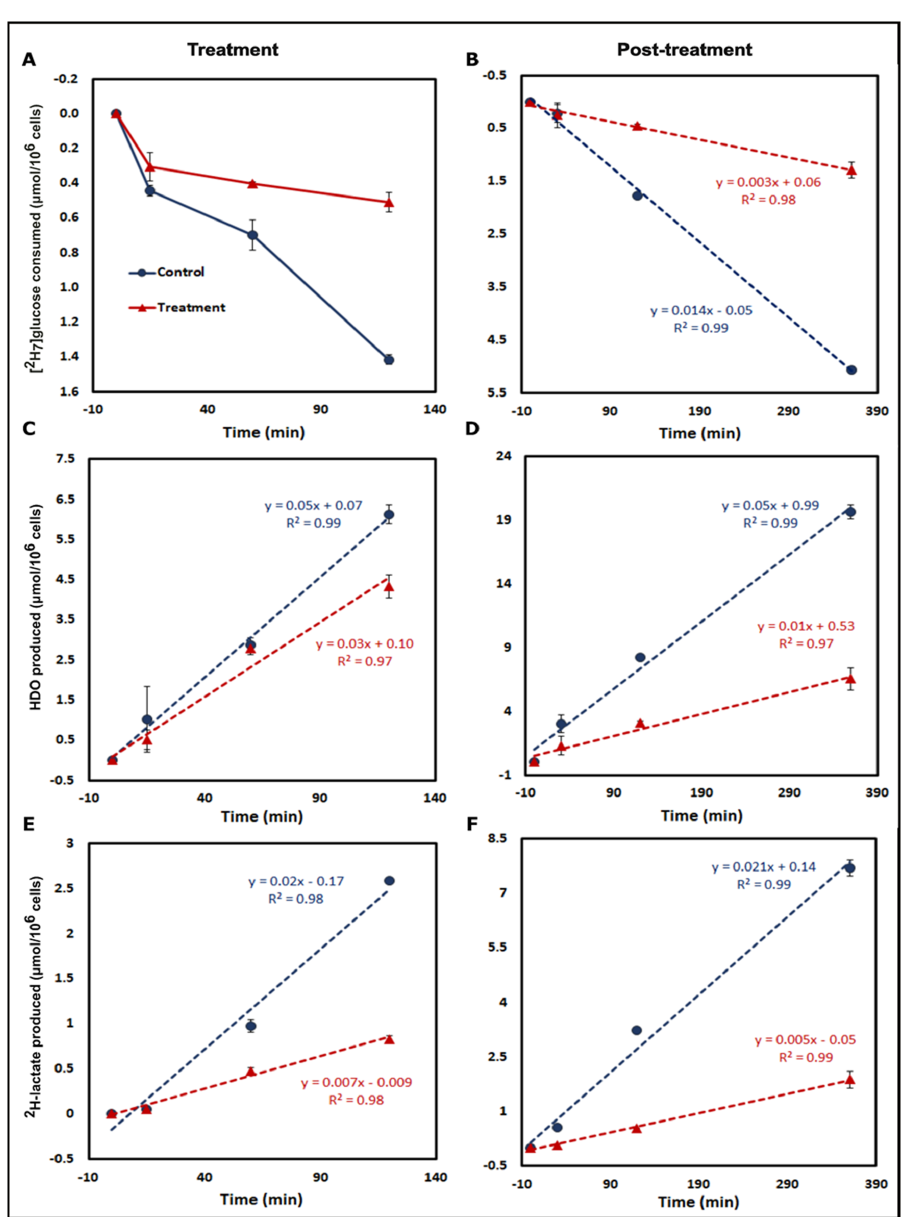
Figure 2. Time course analysis of [ 2 H 7 ]glucose metabolism. Kinetic plots of treatment (1st column) and post-treatment (2nd column) [ 2 H 7 ]glucose metabolism by control and treated A549 cells incu- bated in DMEM with 5.5 mM [ 2 H 7 ]glucose. Analysis of [ 2 H 7 ]glucose consumption for both periods is shown in ( A , B ). The kinetics of HDO production are displayed in panels ( C , D ). Similarly, kinetic data for 2 H-lactate production are shown in panels ( E , F ). Results were calculated from 2 H-NMR data of each of the cell media samples including a blank withdrawn at the 0 min time point for each time period. (Note: [ 2 H 7 ]glucose consumption and HDO and 2 H-lactate production were measured in the cell media samples withdrawn at 0 min, 15 min, 1 h, and 2 h for treatment and 0 min, 30 min, 2 h, and 6 h time points of the post-treatment period. Three biological replicates were used for each group and data are represented as mean ± standard error of mean